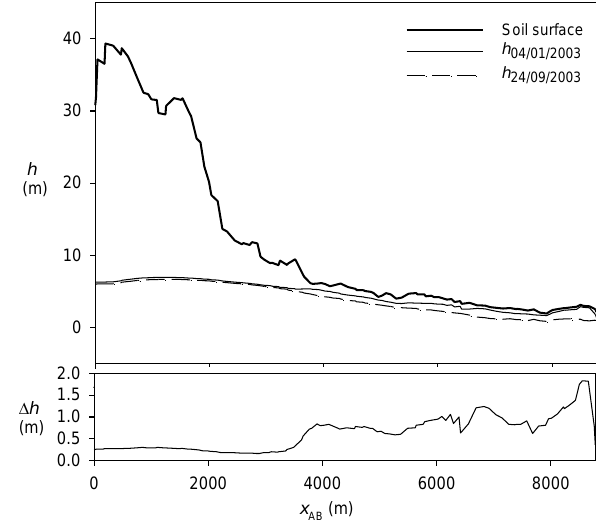
Fig. 7. Simulated groundwater level for 2003 (highest and lowest levels), for the cross-section AB in Fig. 5, and the groundwater level section AB in Fig. 5, and the groundwater level fluctuation ∆ h = h 04/01/2003 – h 24/09/2003. 3 fluctuation 1h = h 4 Jan 2003 – h 24 Sep 2003